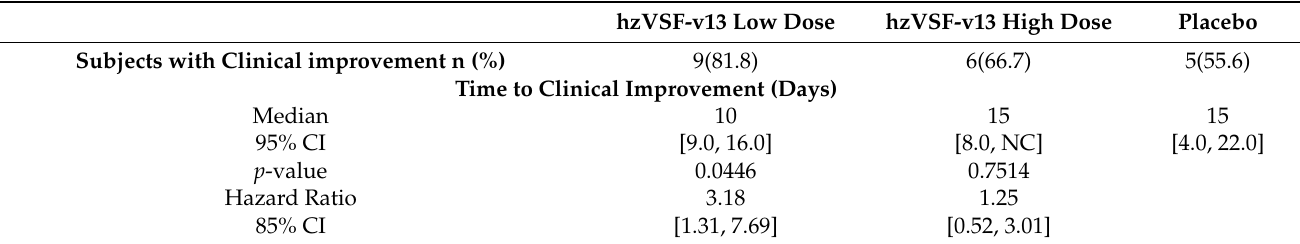
Table 7. Time to clinical improvement in the severe stratum. Clinical improvement is defined as the time from randomization (Day 1) until the first clinical improvement (2-point decreased from the baseline score on the WHO OSCI